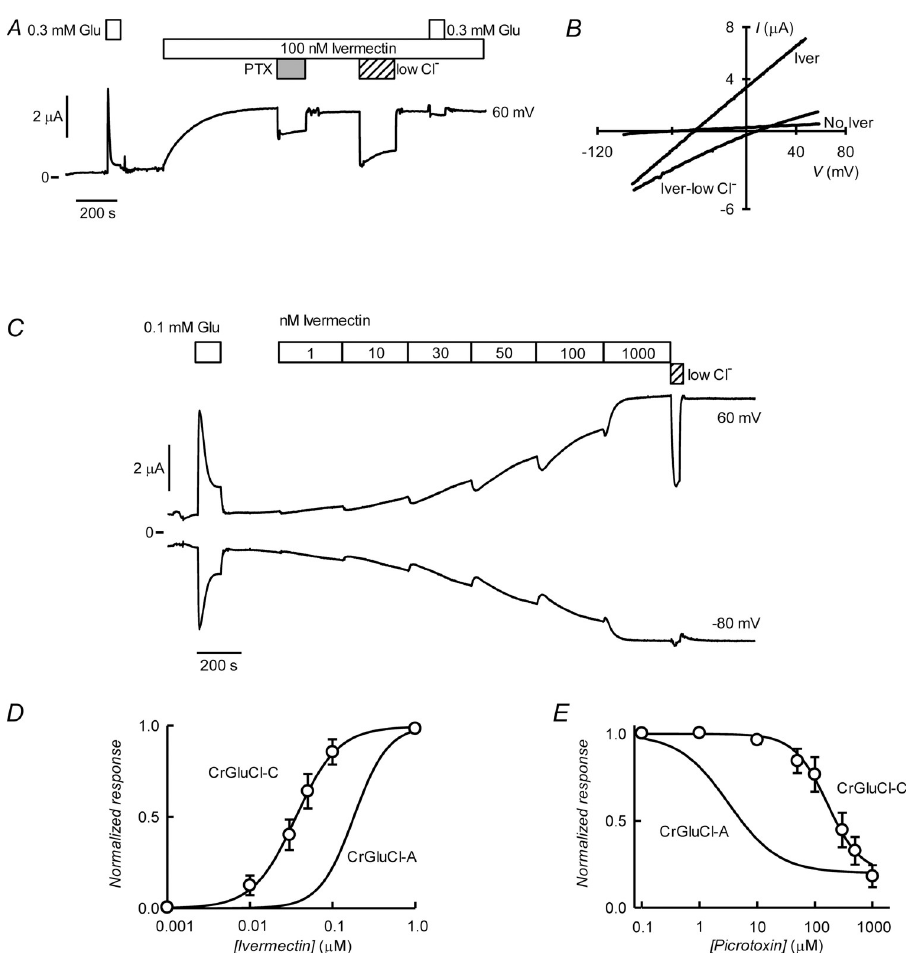
Fig 6. Irreversible activation of CrGluCl-C by ivermectin. A. Current trace obtained at 60 mV during bath application of 300 μ M glutamate and then ivermectin at 100 nM during the times shown in the boxes. The effect of PTX addition at 100 μ M and the reduction in extracellular chloride concentration are also shown. B. Current voltage relations taken from voltage-ramps applied during the experiment in A before and after ivermectin addition as well as after superfusion with the low chloride solution. C. Effect of increasing concentrations of ivermectin on CrGluCl-C and the effect of partial external chloride removal. D. Effect of increasing concentrations of ivermectin on CrGluCl-C reported as average dose dependence of the response. Data (mean ± SD, n = 7) are normalized to the maximal effect of ivermectin. The line is a fit of the Hill equation to the values and it is compared to that measured for CrGluCl-A previously [34]. E. Effect of increasing concentrations of picrotoxin on CrGluCl-C current elicited by 1 μ M ivermectin. Data (means ± SD, n = 9) are normalized to ivermectin-dependent current value before PTX addition. The line is a fit of the Hill equation to the values and it is compared to that measured for CrGluCl-A previously [34]. response of CrGluCl-C to ivermectin and a Hill equation fit to the data. Separate fits to data yielded an EC value of 31.1 ± 14.4 nM and n of 2.1 ± 0.67 (means ± SD, n = 7). These com- 50 H pare with values of 181 nM for EC and n of 2.1 previously reported for the CrGluCl-A sub- 50 H unit [34]. Maximal current reached at saturating ivermectin concentration was 3.7 ± 1.3 μ A (n = 10), which compares with 3.5 ± 1.7 μ A for the maximal current elicited by glutamate. As seen above the sensitivity of CrGluCl-C to PTX appears lower than those of subunits A and B. This was explored further in the PTX inhibitory dose-response in Fig 6E. PTX inhibited ivermectin-induced CrGluCl-C current with an IC of 275 ± 96 μ M (n = 7) and n -1.2 ± 0.22 50 H (n = 7). PTX potency for CrGluCl inhibition is therefore two orders of magnitude lower than